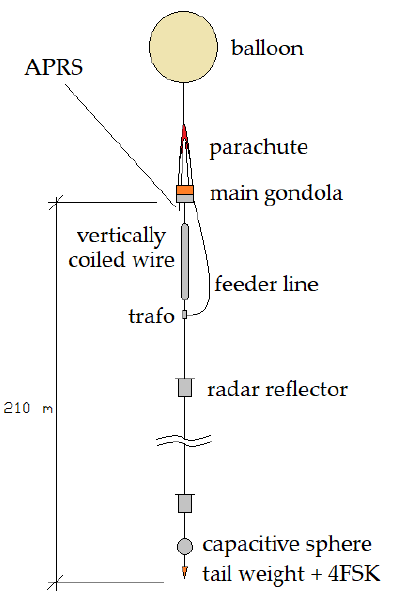
Figure 6. The schematic of the VLF fully airborne VLF transmitting system.